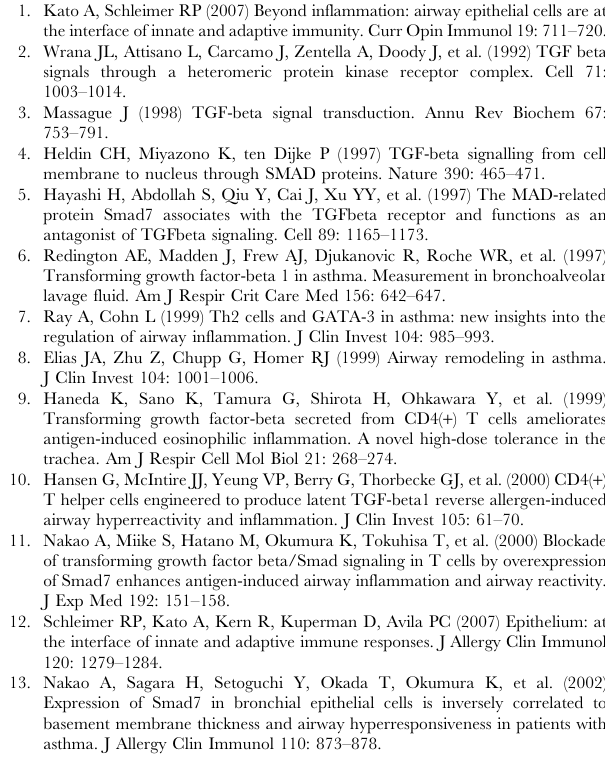
Figure 4. Overexpression of Smad7 in airways increased the lung carcinogenesis following exposure to Urethane. (A) Adenomas (shown by arrows) are visible on the surface of the lungs of wild type and CC10-Smad7 mice following exposure to urethane. Note that the number of adenoma in the Smad7 transgenic mice is substantially increased. (B) Average number of tumors per mouse was largely increased in both male and female CC10-Smad7 transgenic mice. The bars shown are average numbers in each group. (C) Gross histology of the lung tumors found in wild type and CC10-Smad7 mice following urethane exposure.